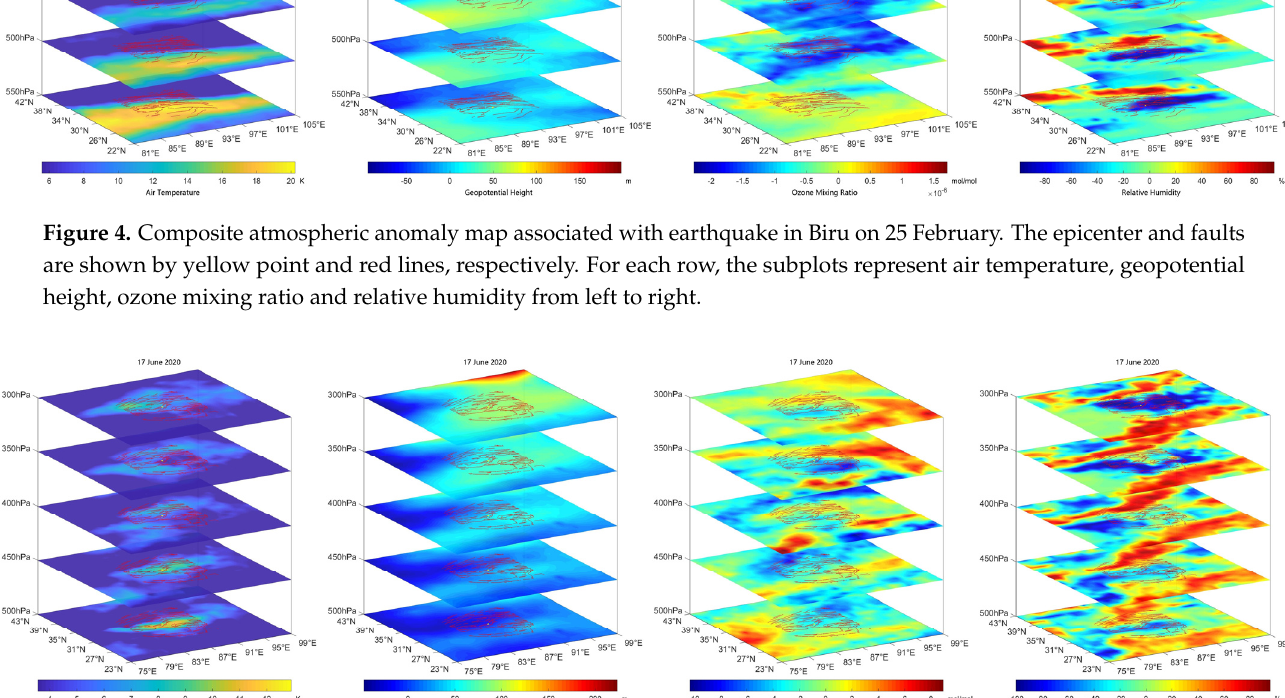
Figure 6. Composite atmospheric anomaly map associated with earthquake in Jiashi on 27 December. The epicenter and faults are shown by yellow point and red lines, respectively. For each row, the subplots represent air temperature, geopo- tential height, ozone mixing ratio and relative humidity from left to right. 4. Discussion Earthquakes occur due to the mechanical process that begins with tectonic stress by subjecting the rocks inside the earth to accumulating energy, culminating in a destructive rupture. Tidal forces act as an external factor, which supplements tectonic stress, exerting